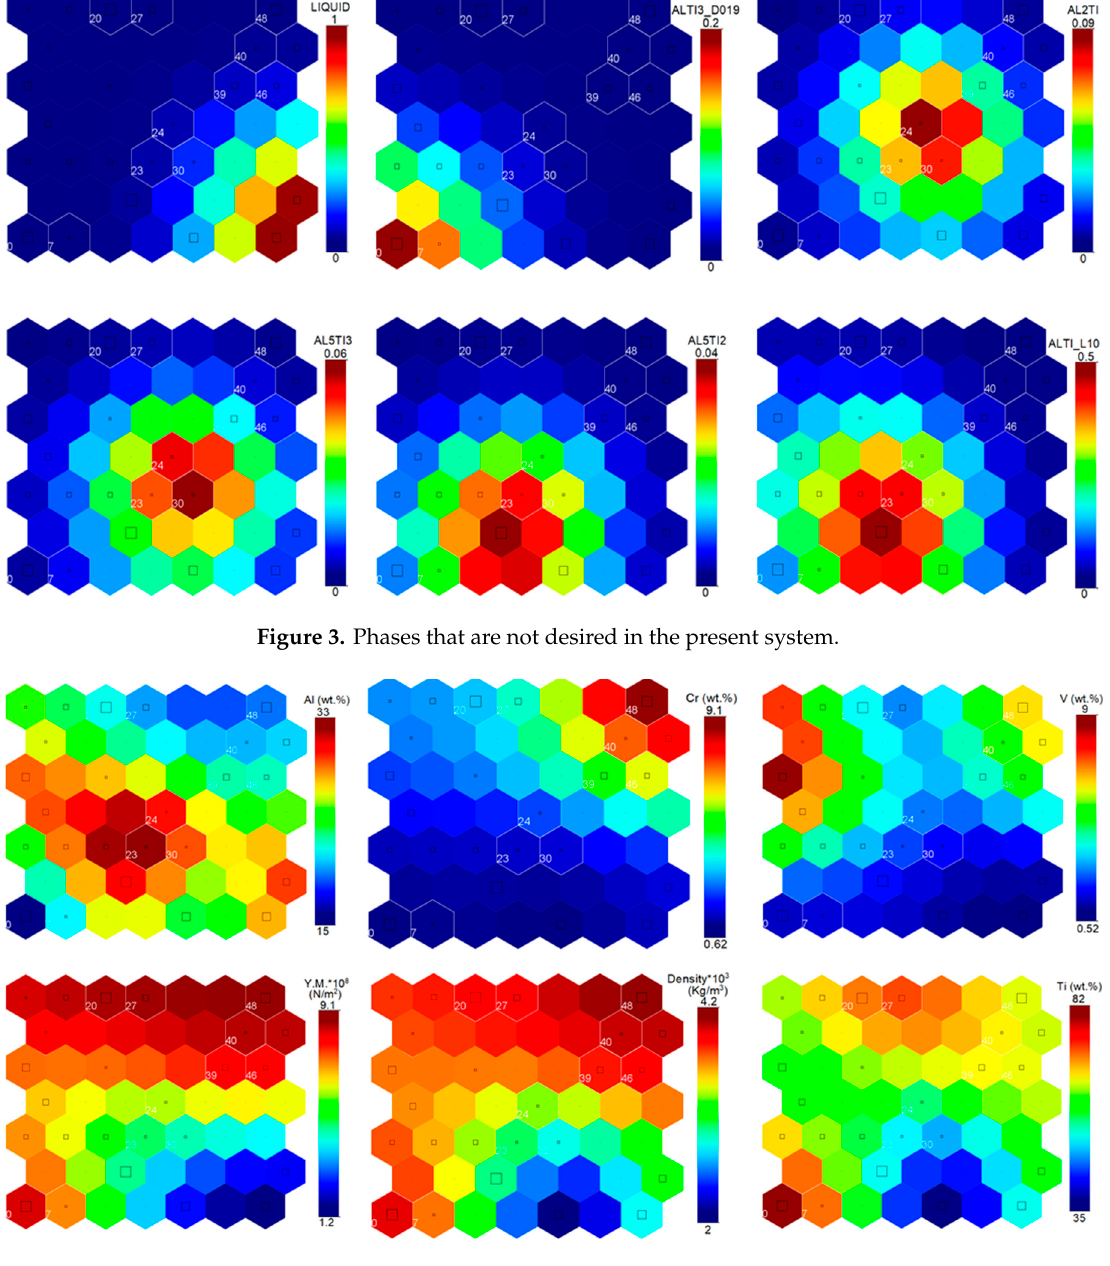
Figure 4. Correlation between alloying elements and desired properties.